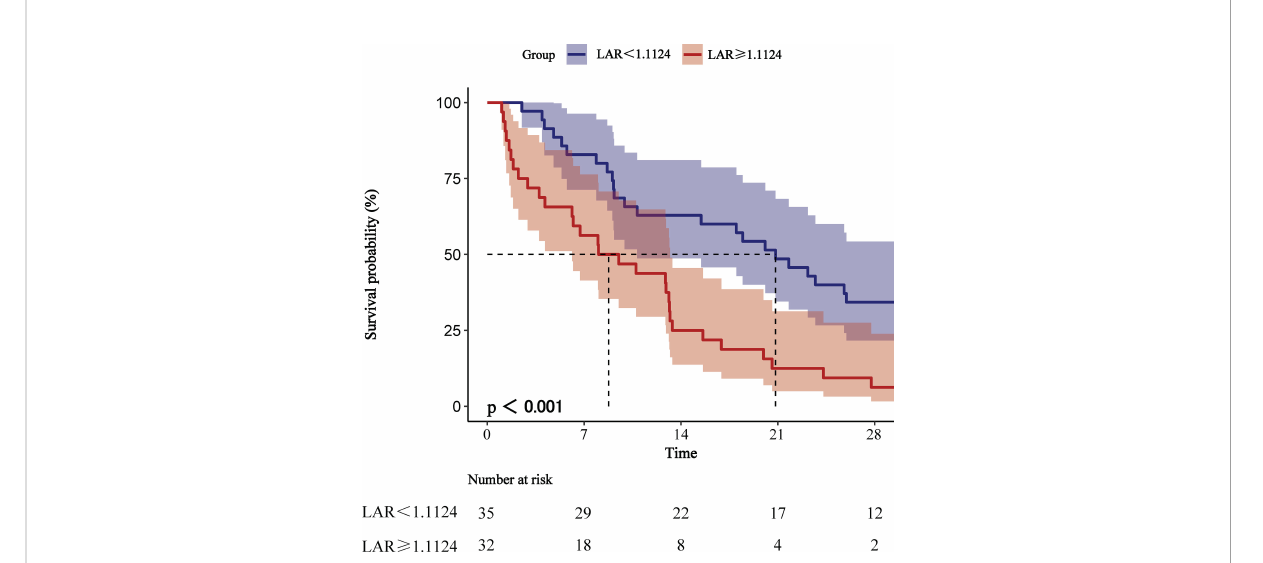
FIGURE 3 Kaplan-Meier survival analysis curves for all-cause mortality within 28-d of hospital